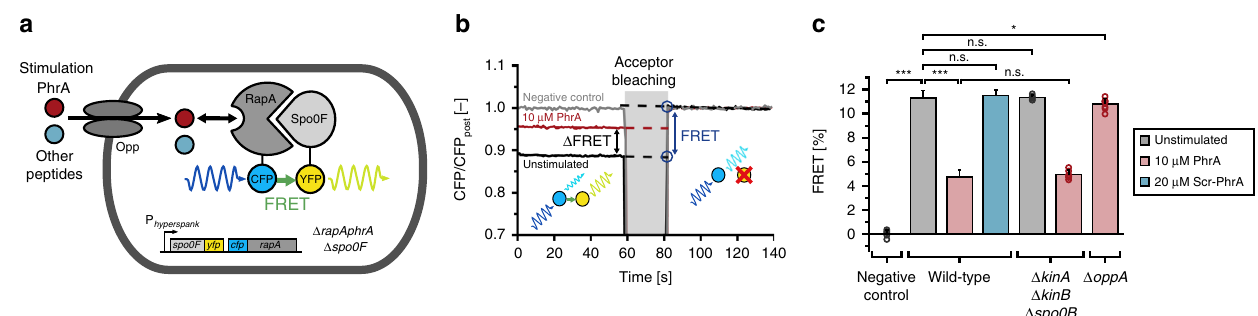
Fig. 3 FRET assay used to study PhrA information processing in Bacillus subtilis . a Scheme of a reporter cell that expresses CFP-RapA and Spo0F-YFP from an IPTG-inducible promoter, in a strain lacking the endogenous signaling components. When RapA and Spo0F form a signaling complex, intermolecular FRET between CFP and YFP occurs. Upon uptake of PhrA or other peptides by the oligopeptide permease Opp, PhrA binds to RapA and thus perturbs the interaction of RapA with Spo0F, thereby altering FRET. b Representative CFP trajectories from acceptor-photobleaching experiments with populations of unstimulated reporter cells (black line) and reporter cells stimulated with 10 µ M PhrA for 6 min (red line). A FRET-negative control expressing free YFP and CFP is included for reference (gray line). YFP was bleached for 20 s to abolish FRET, which resulted in a corresponding increase in CFP emission. The FRET ef fi ciency was calculated from the ratio of CFP emission before (CFP pre ) and after (CFP post ) photobleaching (blue circles), as determined by linear fi ts to the data (dashed lines). A relative increase in CFP emission that exceeds 0.6% is scored as signi fi cant, i.e., as indicating level of donor – acceptor FRET. c Barplot of FRET ef fi ciencies derived from peptide stimulation experiments from left to the right: a FRET-negative control (BIB138), wild-type reporter cells (BIB625), a kinA kinB spo0B mutant (BIB1993) and a oppA mutant (BIB1563). Error bars: mean ± SD. Numbers of independent experiments: n e = 160, 112, and 21 for unstimulated, PhrA-treated and Scr-PhrA-treated (a scrambled version of the PhrA pentapeptide) in strain BIB625, respectively. n e = 5 (BIB138), n e = 6 (BIB1993), n e = 8 (BIB1563), respectively. Unpaired t test: n.s.: P > 0.05, *** P < 0.001. See Supplementary Data 1 for further statistical information. Source data are provided as a Source Data fi